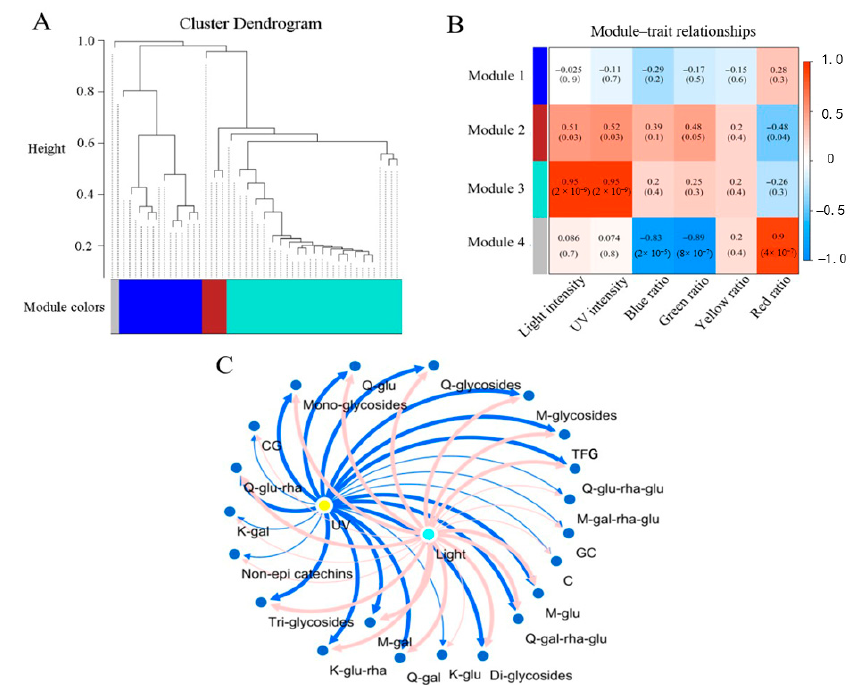
Figure 7. Correlations of flavonoid contents with light parameters via WGCNA. Hierarchical clustering dendrogram ( A ). The modules achieved are shown with correlation coefficients (upper) and p values (lower) annotated in each cell ( B ). Correlation network of light intensity (aquamarine blue node), UV intensity (yellow node) and the contents of flavonoids (blue nodes) for module 3 ( C ). The co-expression network construction was performed using Cytoscape software (version 3.8.0). The line width was increased in response to the elevated correlation coefficient from 0.204 to 0.825.